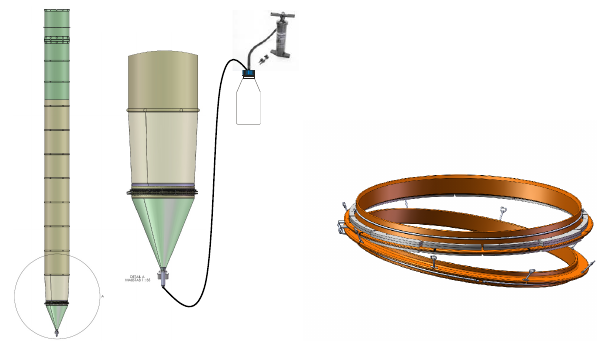
Fig. 4. Left: sketch of sediment trap used in 2011 and 2012 cam- paigns. The funnel-shaped trap made of TPU foil is connected to the bottom of the enclosure bag via a flange (right panel). Note the tapering of the lowest section of the mesocosm bag. Sampling of sedimented matter is achieved via a silicon tube which connects to a 5L sampling flask and a hand-operated vacuum pump. Right: flange ring made of laminated fibreglass to attach the external sediment trap to the lower end of the enclosure bag. The upper ring (con- nected to the bag) is equipped with steel weights to facilitate the sinking of the enclosure bag during mesocosm filling and to keep the bag in vertical position when exposed to currents. Bag and sed- iment trap are fixed to the upper and lower flanges by stainless steel clamps pressing the TPU foil in notches. Upper and lower flanges are connected with eight screws and sealed with a silicon rubber